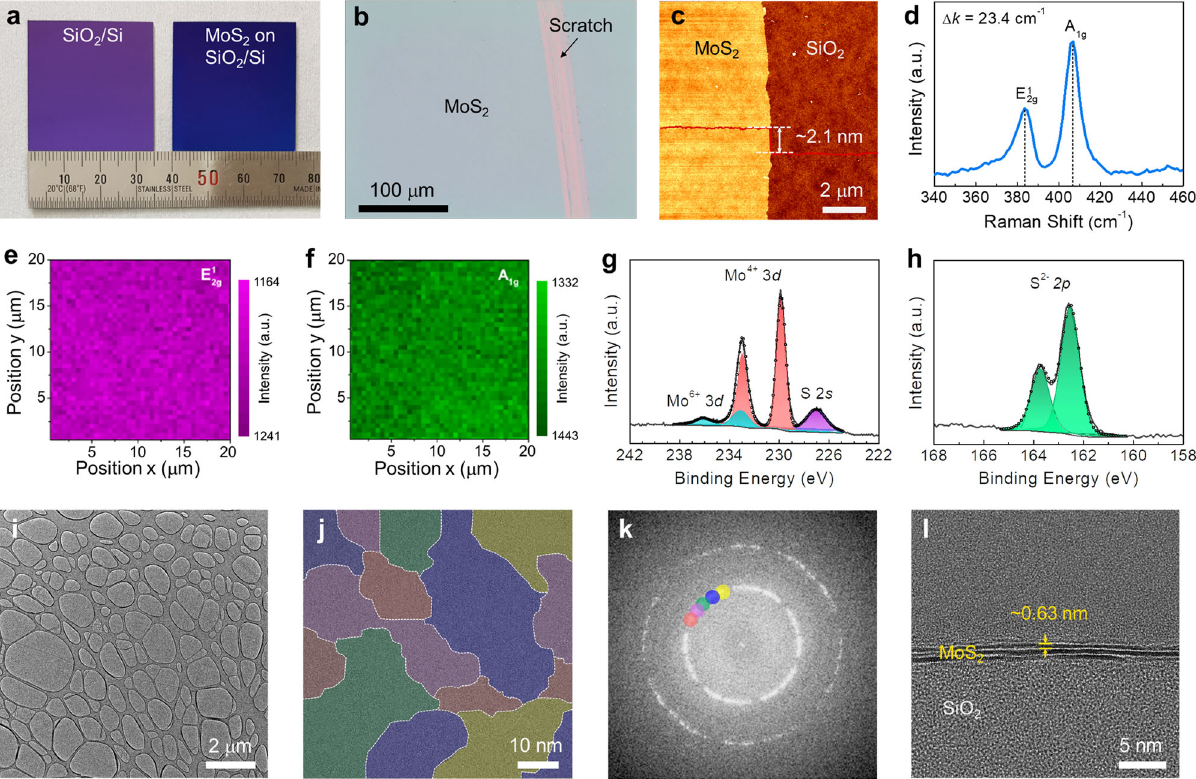
Fig. 1 Characterization of large area grown trilayer MoS 2 fi lm. a Photographs of a bare SiO 2 /Si substrate (left) and MoS 2 fi lm grown on SiO 2 /Si substrate (right). b Optical image of the highly uniform as-grown MoS 2 fi lm on SiO 2 /Si substrate. The scratch was intentionally introduced to be able to distinguish between the MoS 2 fi lm and the SiO 2 /Si substrate. c AFM topography and height pro fi le of the synthesized MoS 2 fi lm indicating the thickness of a trilayer (~2.1 nm). d Raman spectrum of the trilayer MoS 2 fi lm at an excitation of 532 nm. e , f Raman mapping images of the intensity of the E 1 2g and A 1g modes, respectively. g , h XPS characterization of the Mo 3d and S 2p core levels of